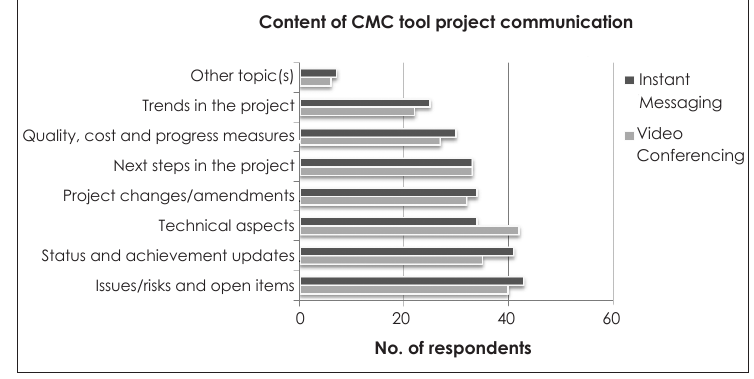
Figure 5: Content of CMC communication in projects The results of the survey showed that the majority of the IM project content consists of issues/risks and open items, status and achievement updates, project changes/amendments, and technical